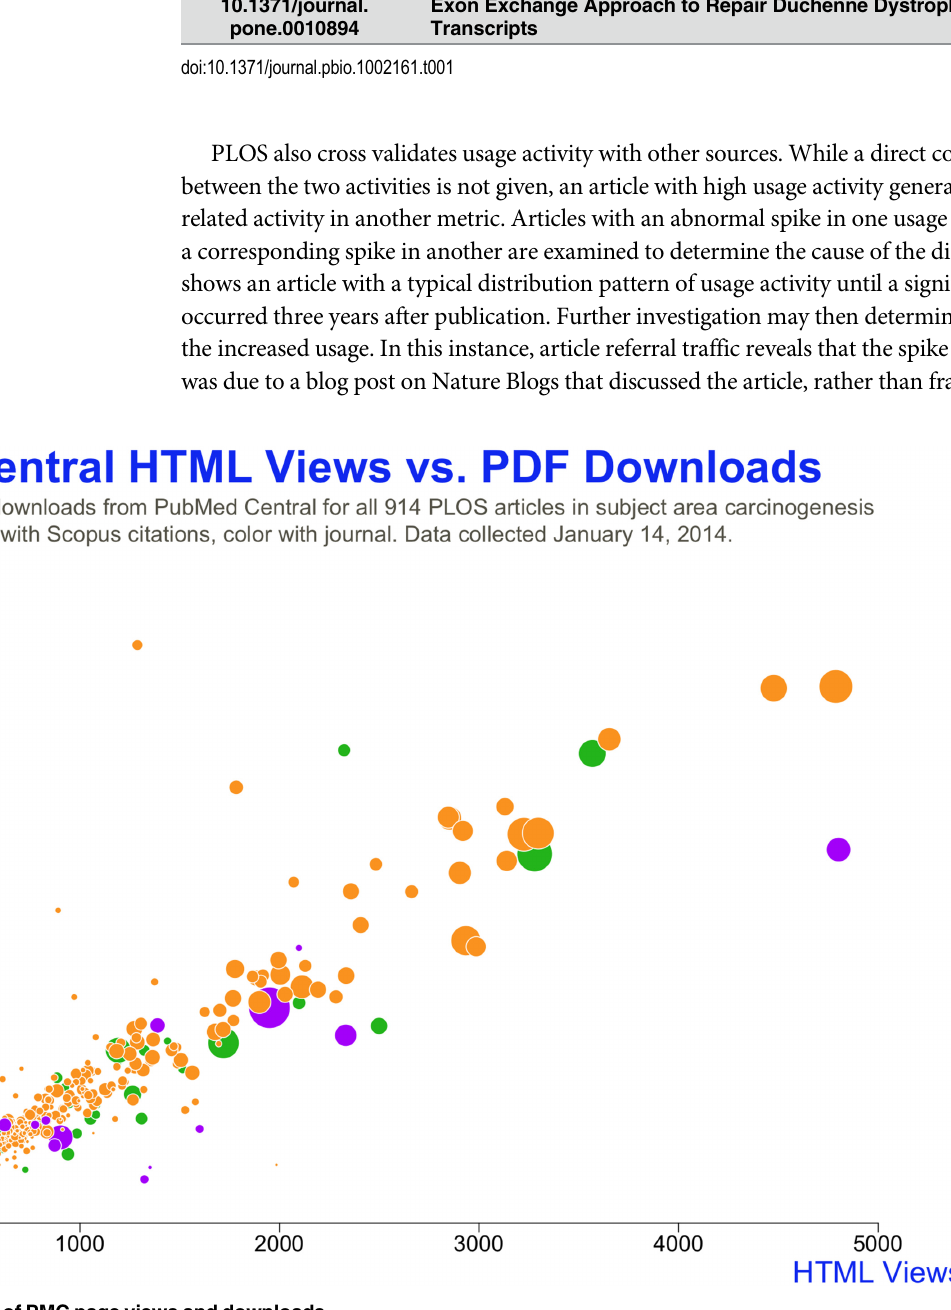
Fig 3. PLOS comparison of PMC page views and